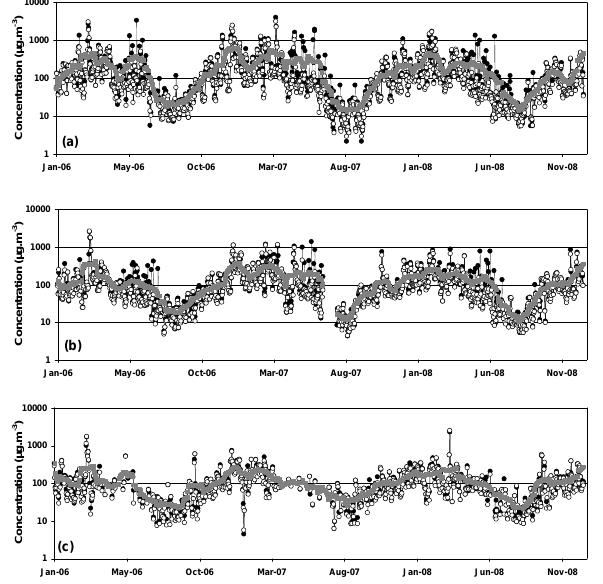
Fig. 5. Daily mean air humidity (black) and daily precipitation (dark grey) measured in Banizoumbou (a) , Cinzana (b) and M’Bour (c) from January 2006 to December